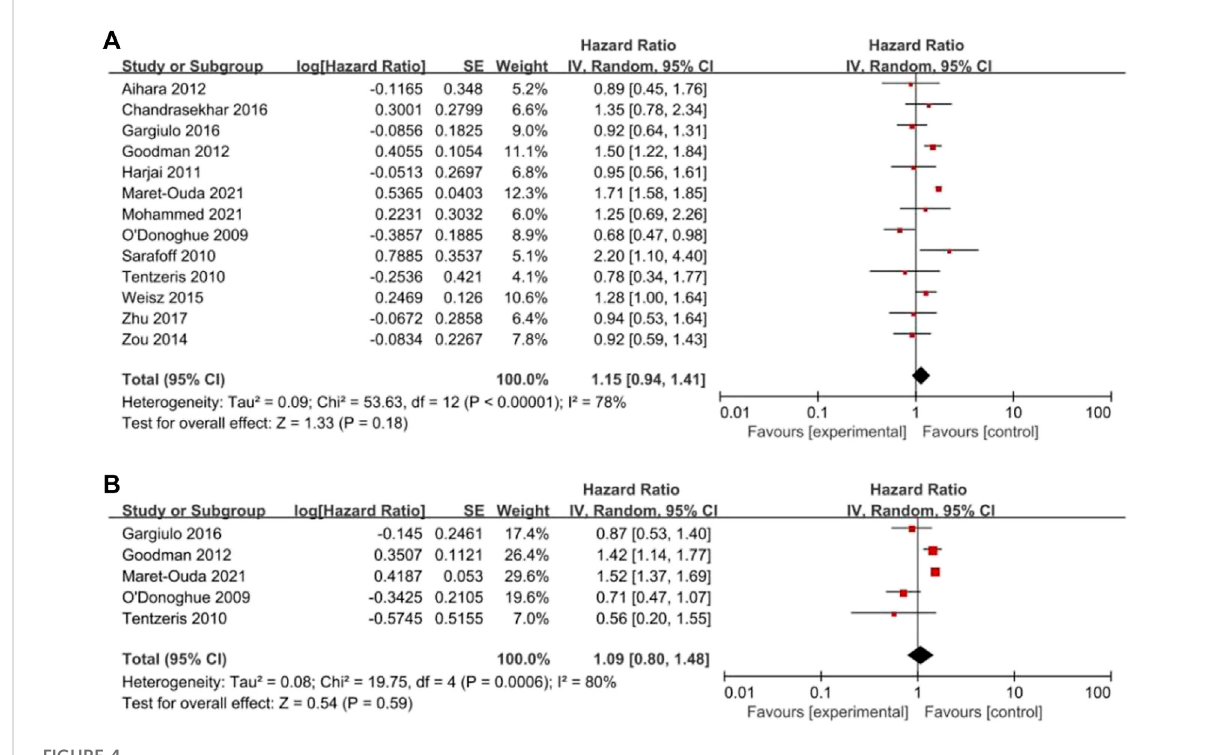
FIGURE 4 Forest plots of (A) all-cause mortality and (B) cardiac death.